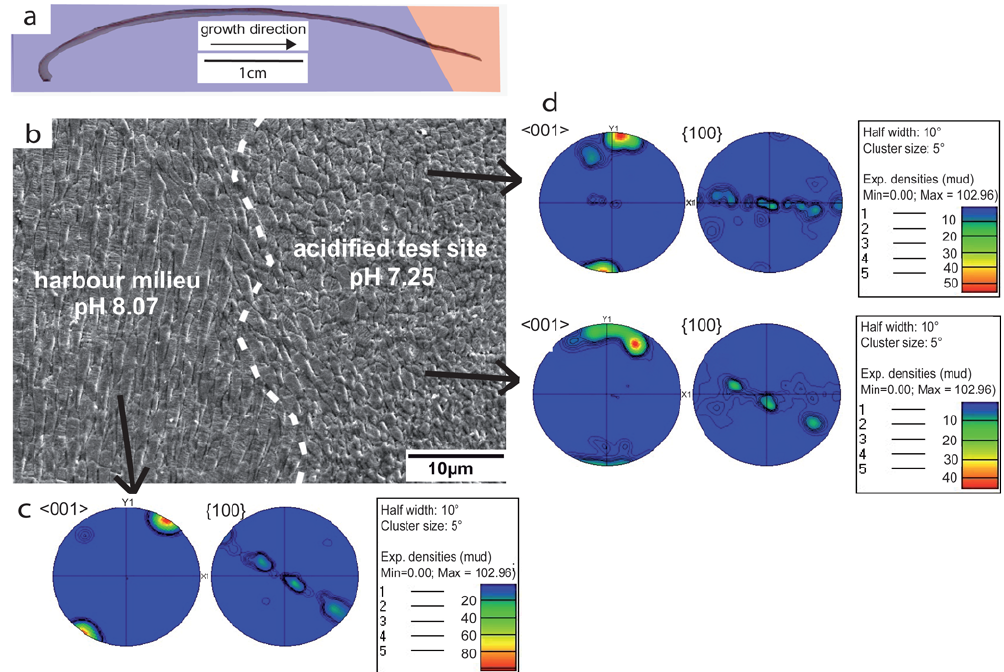
Fig. 4. Thin section view of calcite layer of M. galloprovincialis from acidified seawater site B1. (a) Blue colour indicates shell precipitated prior to transplantation and red colour indicates shell precipitated after transplantation to acidified test site B1. (b) SEM image of shell precipitated parallel to the longest growth axis and directly before and after transplantation. Note pronounced differences in the orientation of the calcite layer across transplantation event (white, stippled line). Locations of respective pole figures (c) and (d) are indicated. ( c and d ) Pole figures representing stereographic projections of crystallographic axes and planes. The strength of clustering is specified with the MUD (multiples of uniform density) value that gives the distribution pattern of EBSD data relative to that of a random distribution.